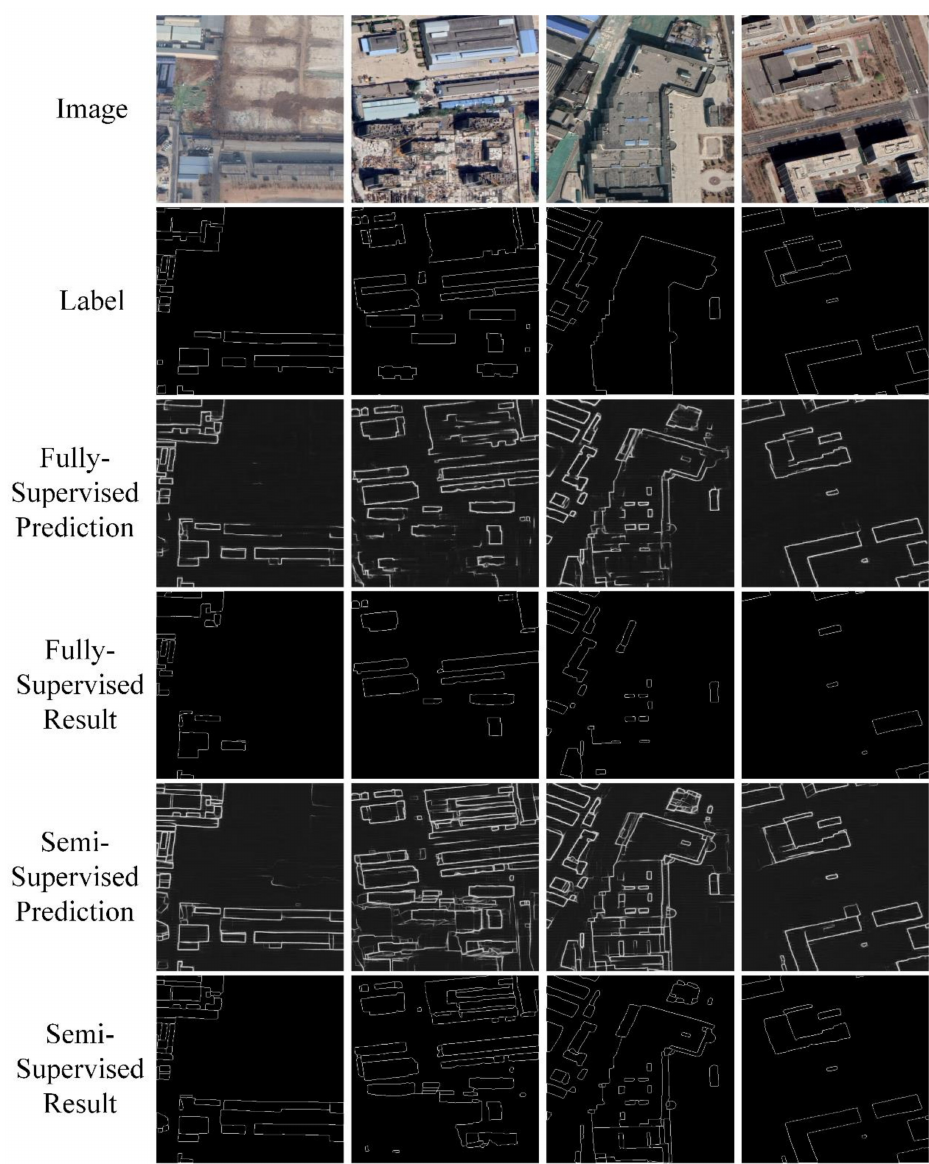
Figure 9. The results of building extraction for fully supervised and semi-supervised methods in neighboring distinctions. The semi-supervised method uses the 50% labeled dataset and the 100% unlabeled dataset, while the fully supervised method uses the 100% labeled dataset and the 0% unlabeled dataset. The image is the original image taken in Beijing from Google Earth. The label is the ground truth of the image. Prediction is the edge strength map, which is the result of our network. The fully supervised and semi-supervised results are the complete edges, which, after post-processing, include binarization and thin, incomplete boundary